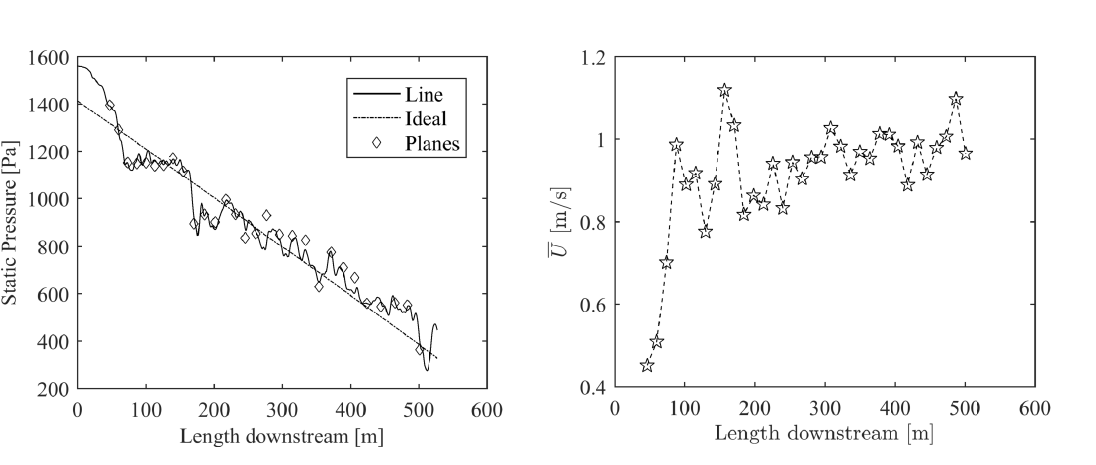
Figure 4. ( Left ) the solid line represents the pressure modelled at the centre of the tunnel, while the dotted line represents the ideal case with no variation in hydraulic radius. The data represented by diamonds is the static pressure area-averaged over each of the cross-sections. ( Right ) area averaged velocity from the entrance to the outlet of the